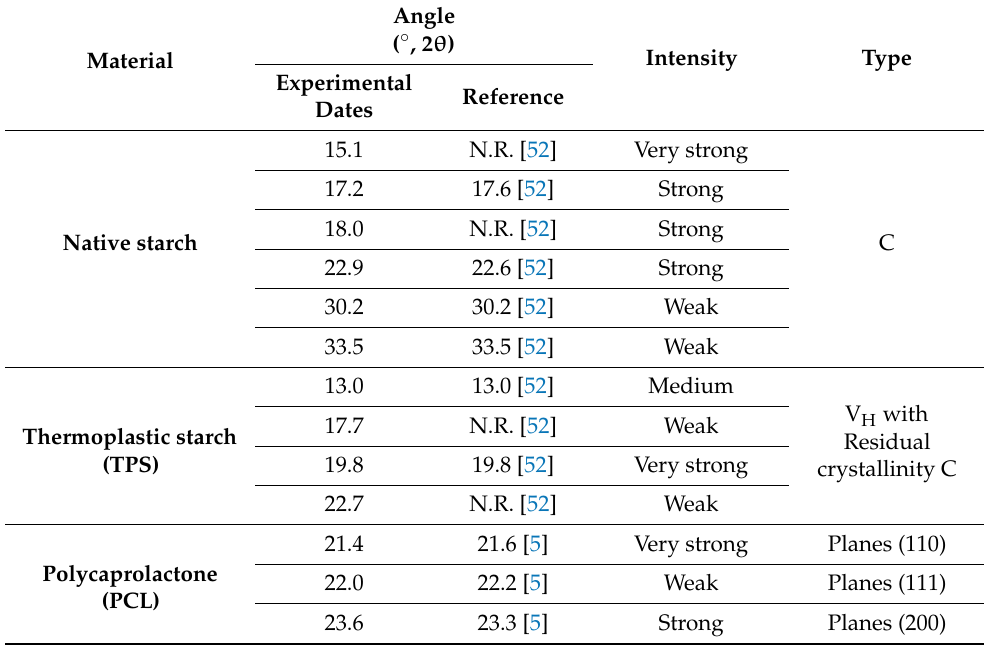
Table 3. Data corresponding to the diffraction peaks of native starch, TPS, and PCL.